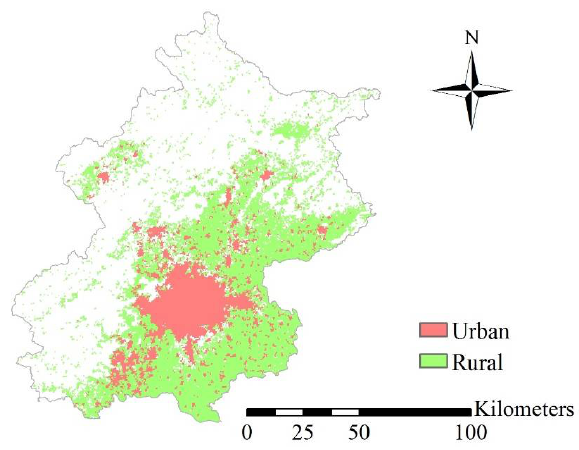
Figure 2. The urban and rural areas of Beijing City in 2010.